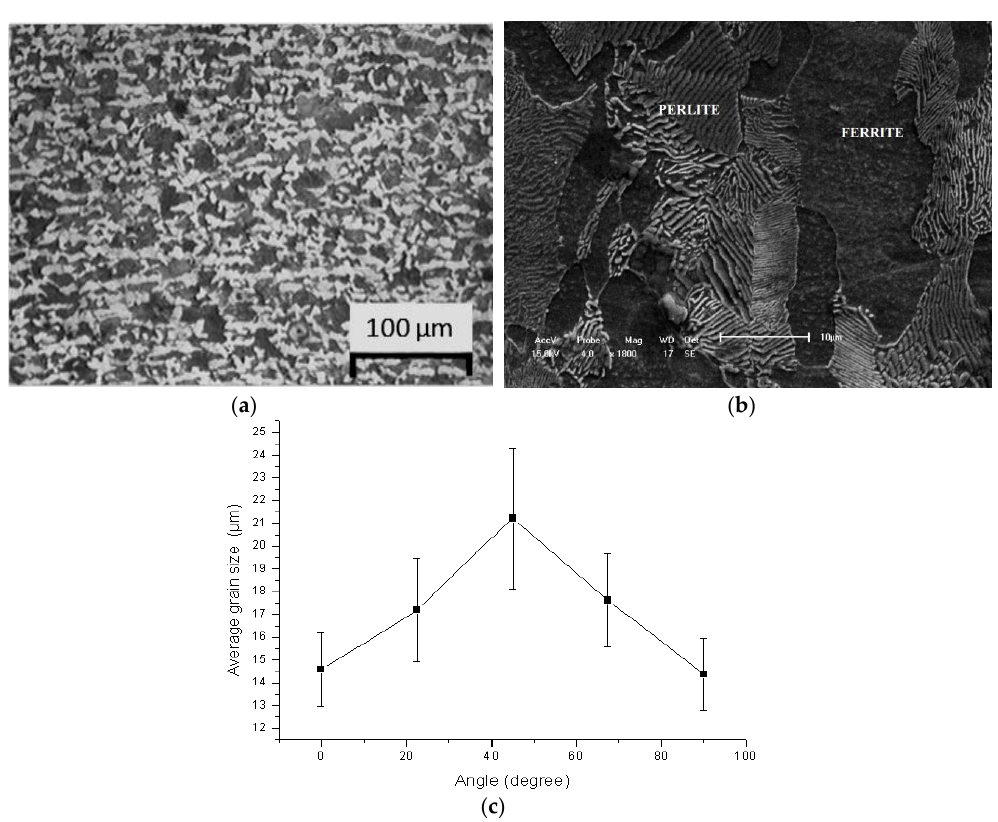
Figure 6. Microstructure of the surfaces where the induced magnetic field measures were collected ( a ); scanning electronic microscopy of the studied surfaces showing the lamellar perlite structure ( b ); and average ferrite grain size versus rotational angle ( c ).